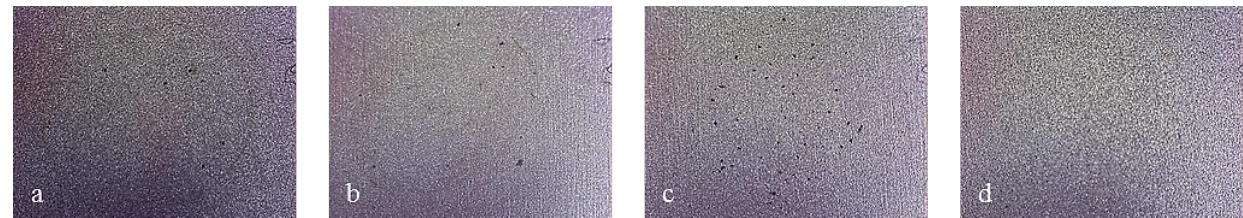
Figure 19. Working area after polarization on X40CrMo15 steel, sandblasted